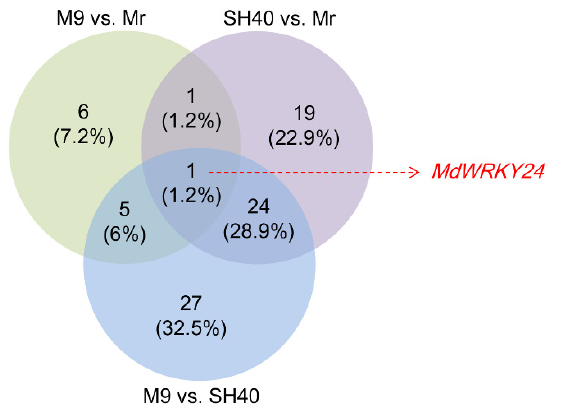
Figure 1. Pairwise comparison of three stock and scion combinations. The numbers of transcription factors with significant differences are indicated in the Venn diagram. M9: Fuji/M9/Mr; SH40: Fuji/SH40/Mr; Mr: Fuji/Mr/Mr. M9 vs. Mr refers to the differences between the means of the three biological replicates of the Fuji/M9/Mr and Fuji/Mr/Mr samples. A similar notation is used for SH40.